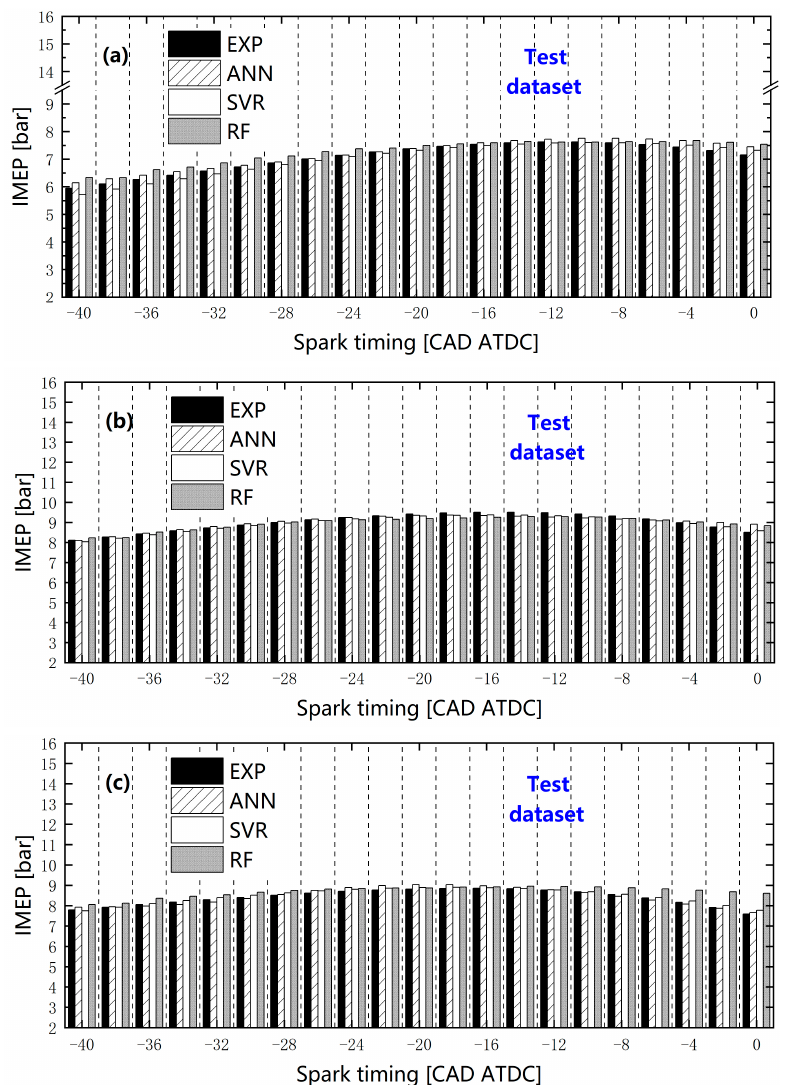
Figure 8. Comparison of predicted IMEP with actual values at medium load: ( a ) low speed; ( b ) medium speed; ( c ) high speed.